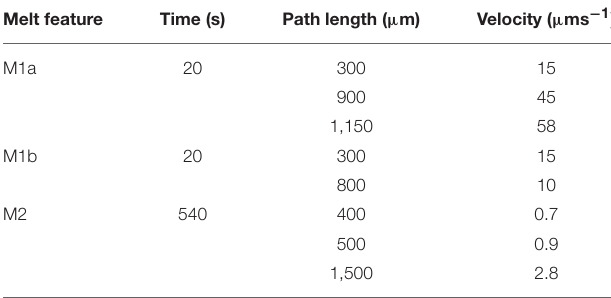
TABLE 1 | Melt velocity estimates for Au melt in identified fracture planes. Melt